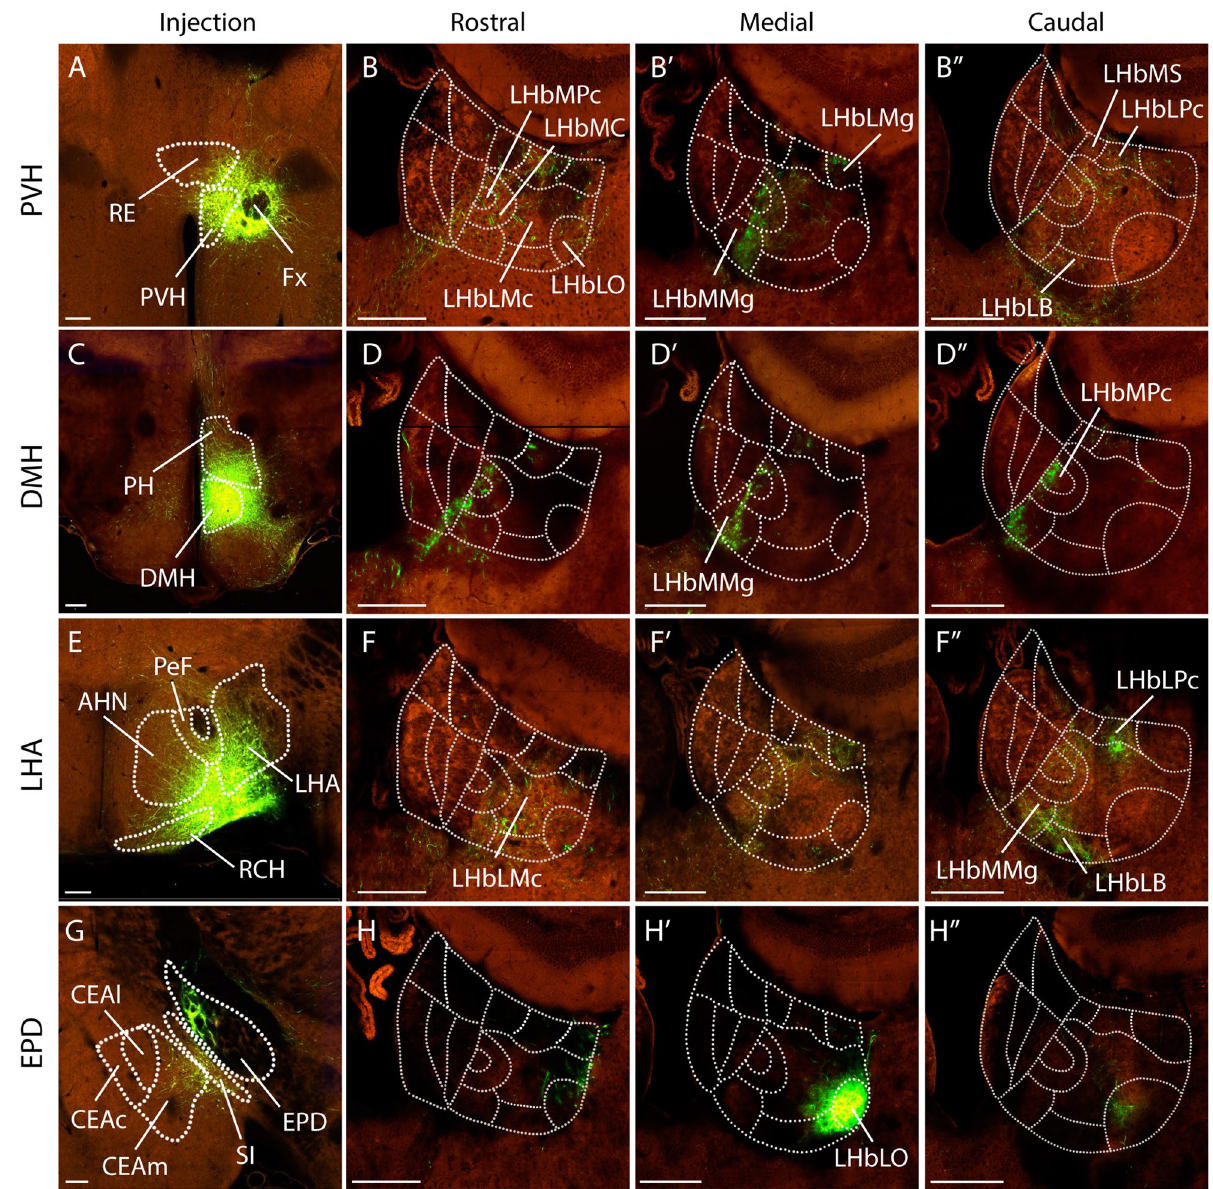
Figure 5. Peduncular hypothalamic projections to the LHb. ( A ) Injection site in the paraventricular hypothalamic nucleus (PVH; Experiment nº: 581,641,279). ( B – B ”) Adult mouse habenula coronal sections, from rostral to caudal, showing the fiber distribution originated from the PVH nucleus. ( C ) Injection site in the dorsomedial nucleus of the hypothalamus (DMH; Experiment nº: 178,283,239). ( D – D ”) Adult mouse habenula coronal sections, rostral to caudal, displaying the fibers distribution coming from the DMH nucleus. ( E ) Injection site in the lateral hypothalamic area (LHA; Experiment nº: 485,239,207). ( F – F ”) Adult mouse habenula coronal sections, rostral to caudal, showing the fibers distribution originated from the LHA nucleus. ( G ) Injection site in the dorsal entopeduncular nucleus (EDP; Experiment nº: 539,498,984, identified as internal segment of globus palidus; GPi). ( H – H ”) Adult mouse habenula coronal sections, rostral to caudal, displaying the fibers distribution coming from the EPD nucleus. Abbreviations: AHN: anterior hypothalamic nucleus; DMH: dorsomedial nucleus of the hypothalamus; EPD, dorsal entopeduncular nucleus; Fx: fornix; LHA: lateral hypothalamic area; LHb, lateral habenula; LHbLB: LHbL basal subnucleus; LHbLMc: LHbL magnocellular subnucleus; LHbLMg: LHbL marginal subnucleus; LHbLO: LHbL oval subnucleus; LHbLPc: LHbL parvocellular subnucleus; LHbM: LHb medial territory; LHbMC: LHbM central subnucleus; LHbMMg: LHbM marginal subnucleus; LHbMPc: LHbM parvocellular subnucleus; LHbMS: LHbM superior subnucleus; PH: posterior hypothalamic nucleus; PVH: paraventricular hypothalamic nucleus; RCH: retrochiasmatic area; RE: nucleus of reuniens. Scale bar: 200 μm. Image credit: Allen Institute for Brain Science. [https:// conne ctivi ty. brain- map.